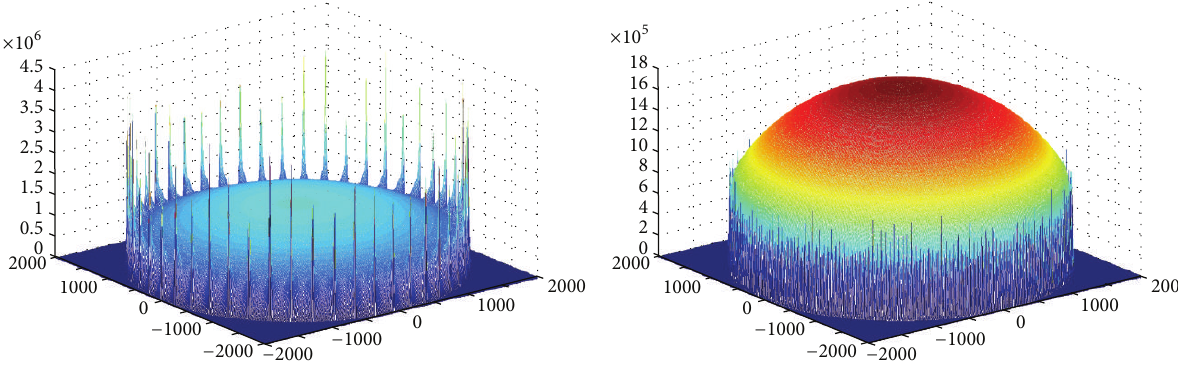
Figure 10: Energy consumption map under different anchor number ( 𝑅 = 2000 , 𝑅 𝑚 = 2000 m, and 𝑟 = 85 ).